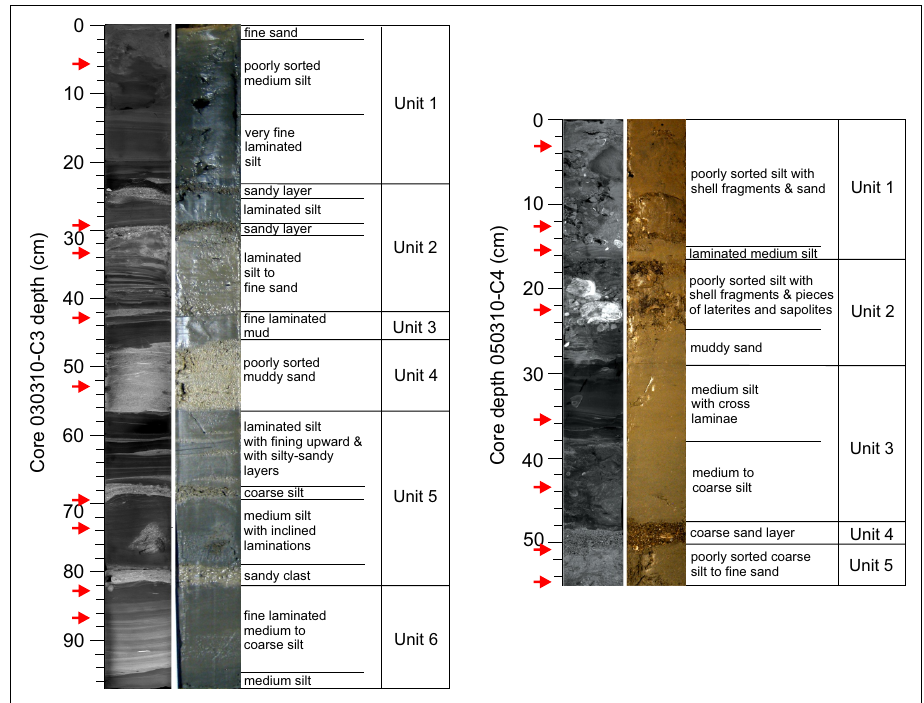
Fig. 2. Photographs, X-radiographs and definition of lithological units of sediment cores 030310-C3 and 050310-C4 versus core depth. The red arrows mark sample positions investigated in the frame of this